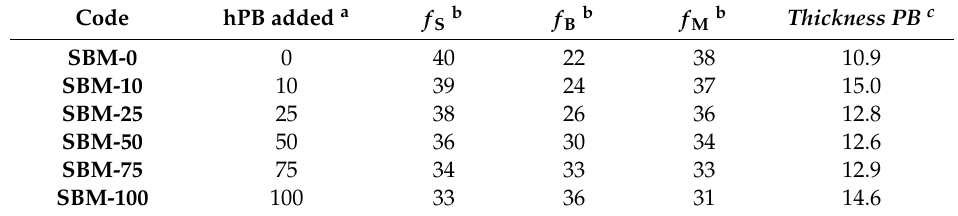
Table 1. Amount of added hPB from 0%–100% relatively to the PB block of SBM and resulting composition of the SBM triblock